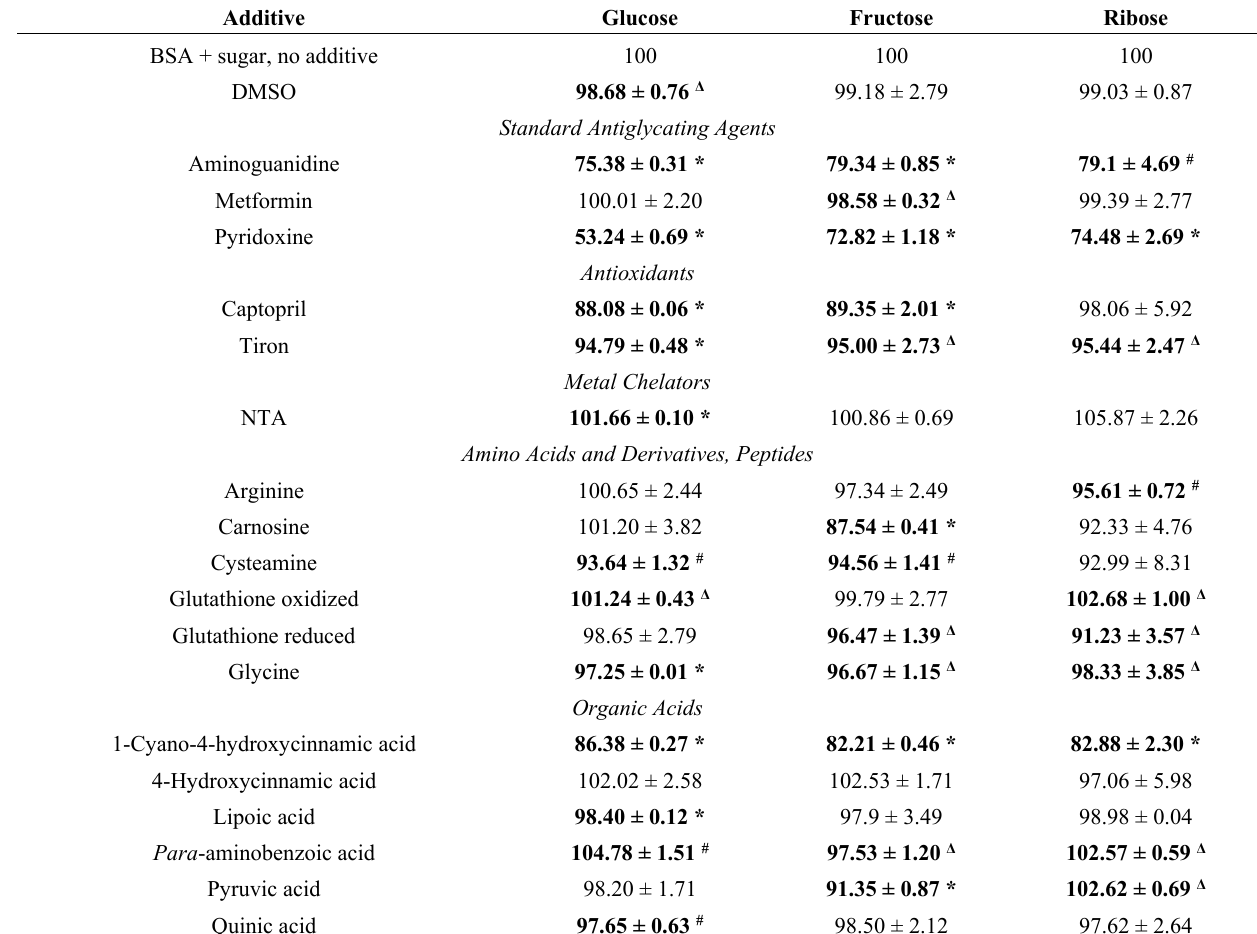
Table 5. The effect of various additives (1 mM) on the glycated albumin content in BSA incubated with glucose, fructose and ribose (0.5 M), estimated with the Bovine Glycated Albumin ELISA Kit. The levels of glycated albumin in samples incubated with sugars only are assumed as 100%; Δ p < 0.05, # p < 0.01, * p < 0.001 (paired Student’s t